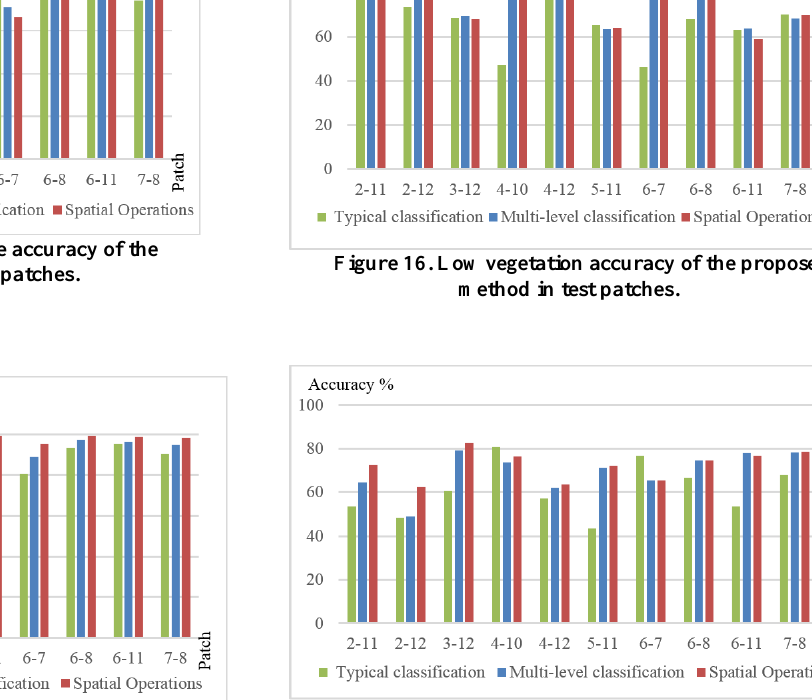
Figure 17. Tree accuracy of the proposed method in test